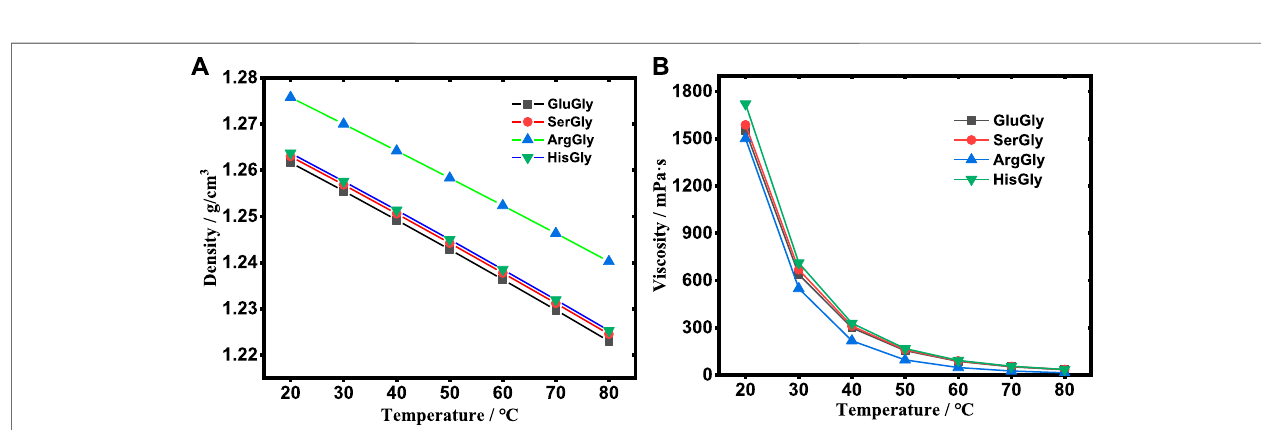
FIGURE 2 | The density (A) and viscosity (B) of NADESs at different temperatures.